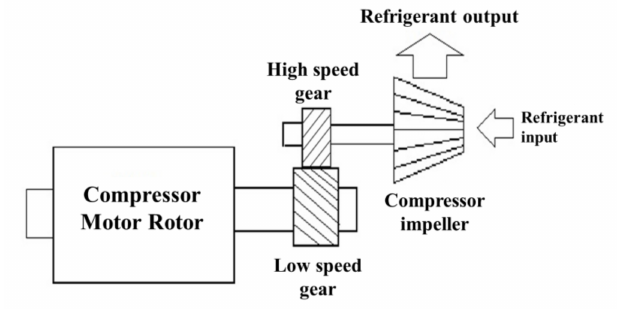
Figure 1. Schematic diagram of centrifugal compressor.